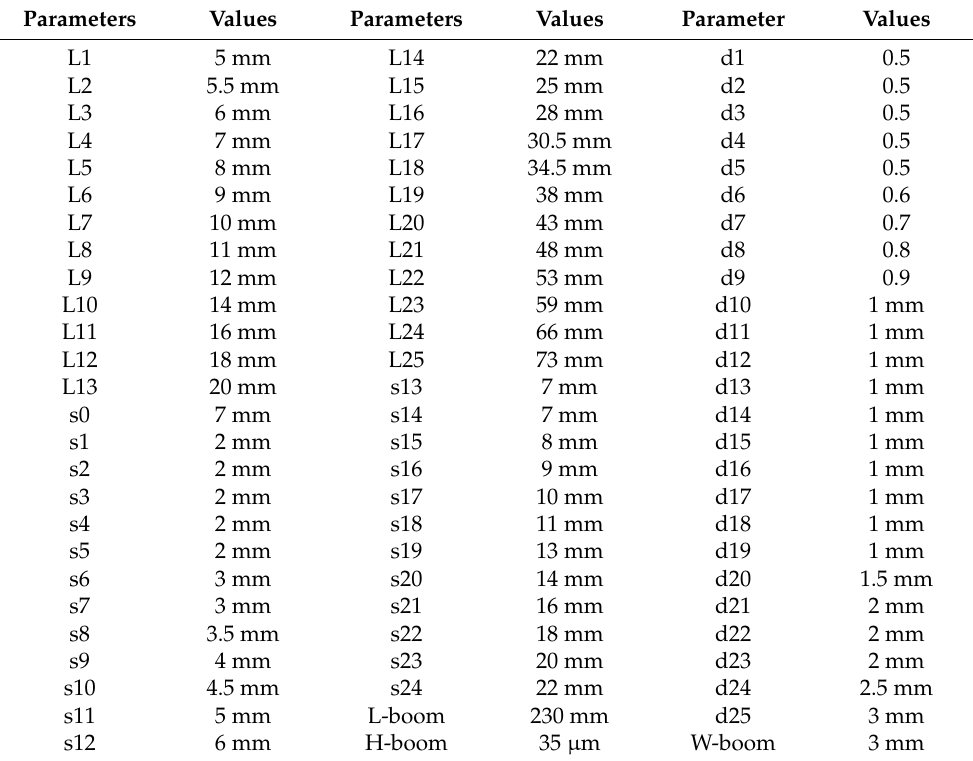
Table 2. Dimensions of the conventional PLPDA antenna. Parameters Values